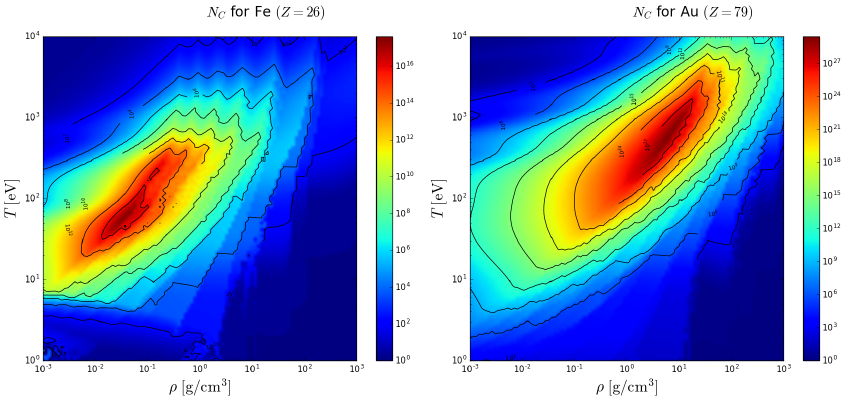
Figure 1. Maps on the temperature-density plane of the number of occupied relativistic configurations (see Equation (12)) for iron (upper pane) and gold (lower pane).